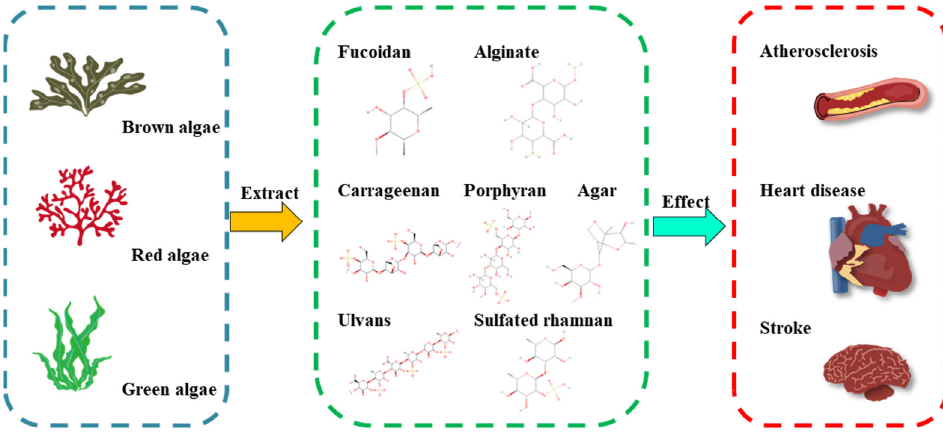
Figure 1. Applications of marine algal polysaccharides in CVD. Brown, red, and green algae contain different types of polysaccharides. Table 1. Structural features and protective effects of polysaccharides from different marine algae.